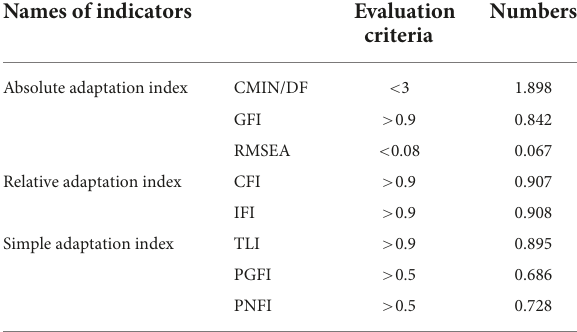
TABLE 1 Verification factor analysis